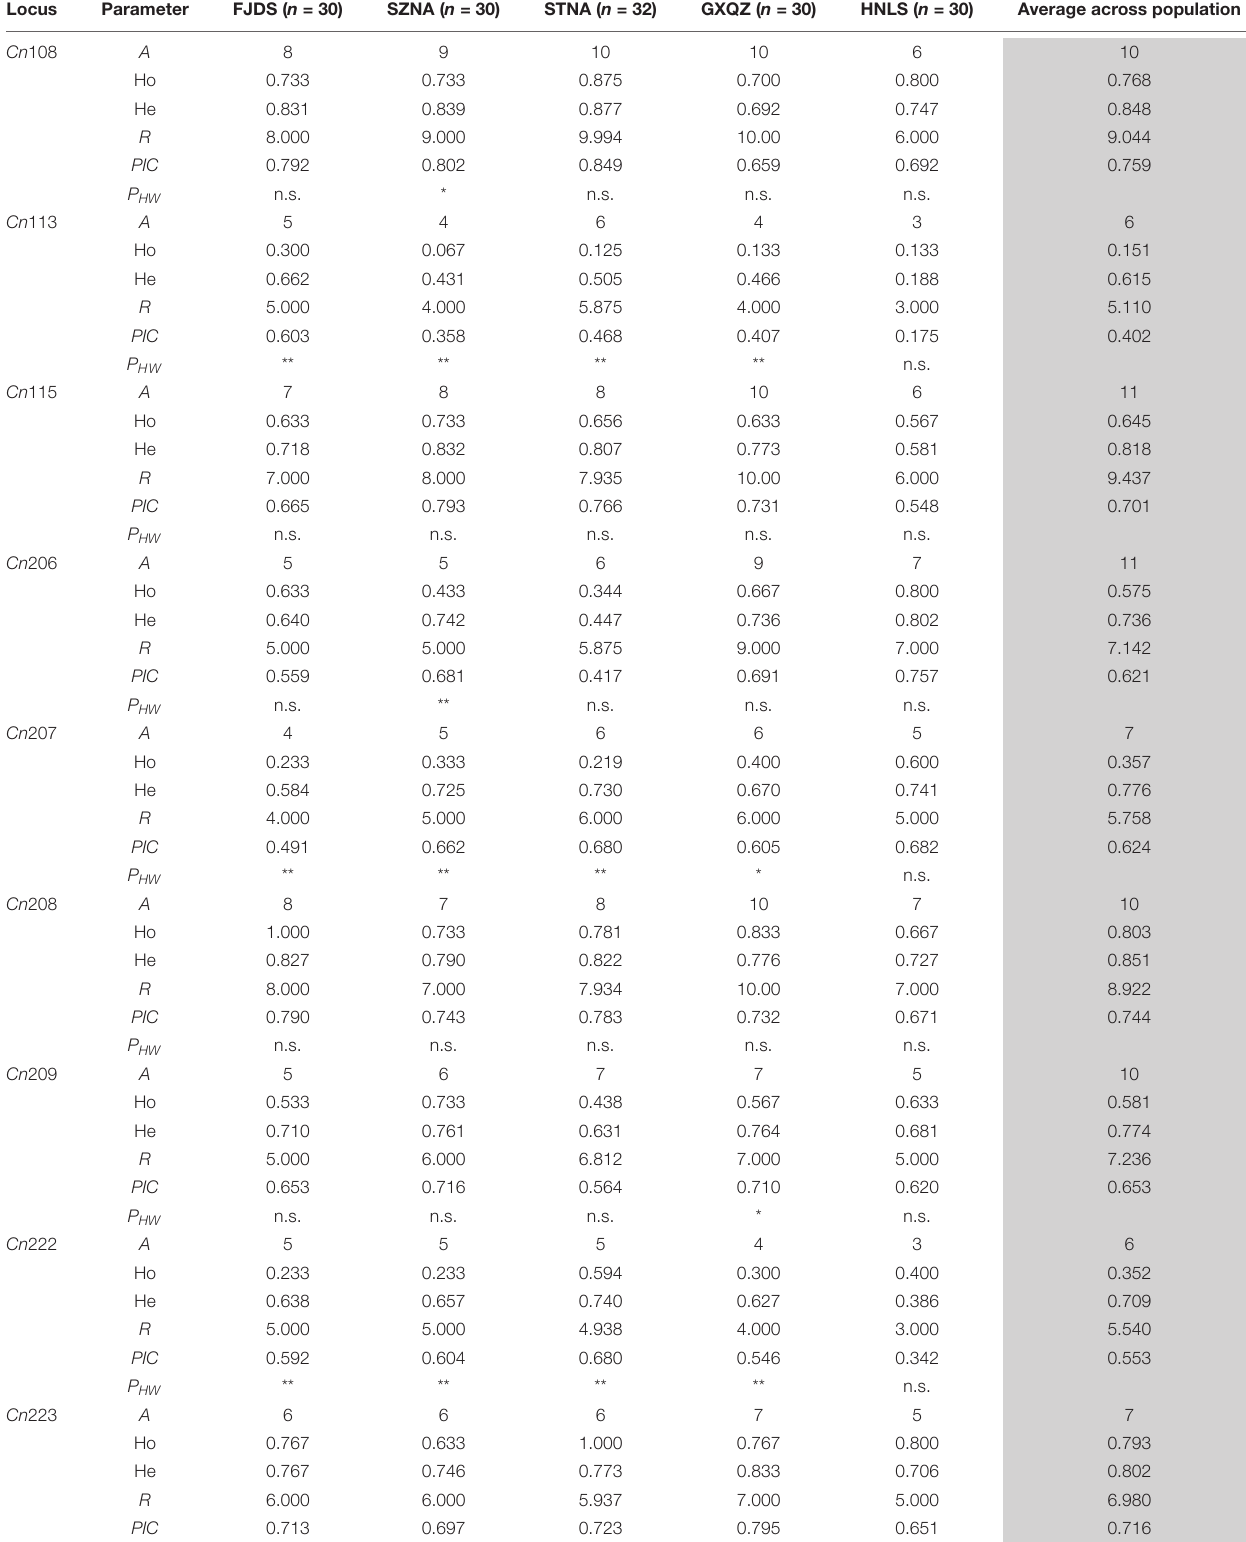
TABLE 2 | Genetic variability of 10 microsatellite loci in five populations for Chlamys nobilis . Locus Parameter FJDS ( n =